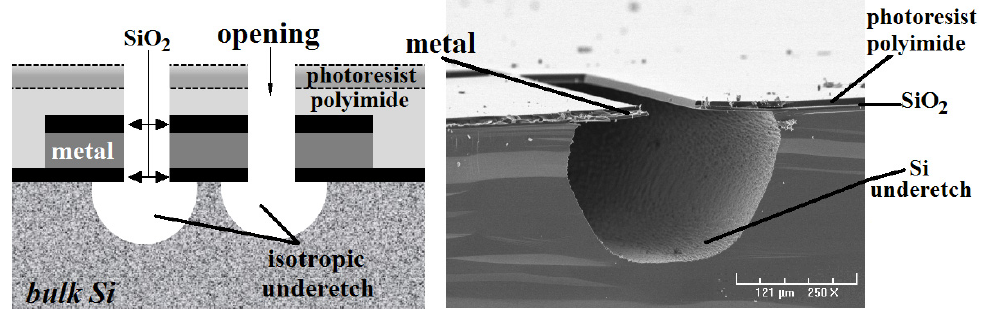
Figure 3. Transverse cross-section and Scanning Electron Microscope (SEM) detail of 160 µm silicon underetch.